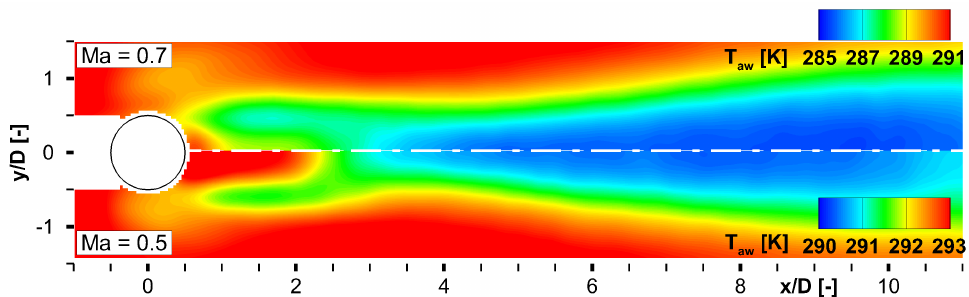
Figure 10. Adiabatic wall temperature distribution in the wake of the cylinder compared for Ma ∞ = 0.7 and Ma ∞ = 0.5.